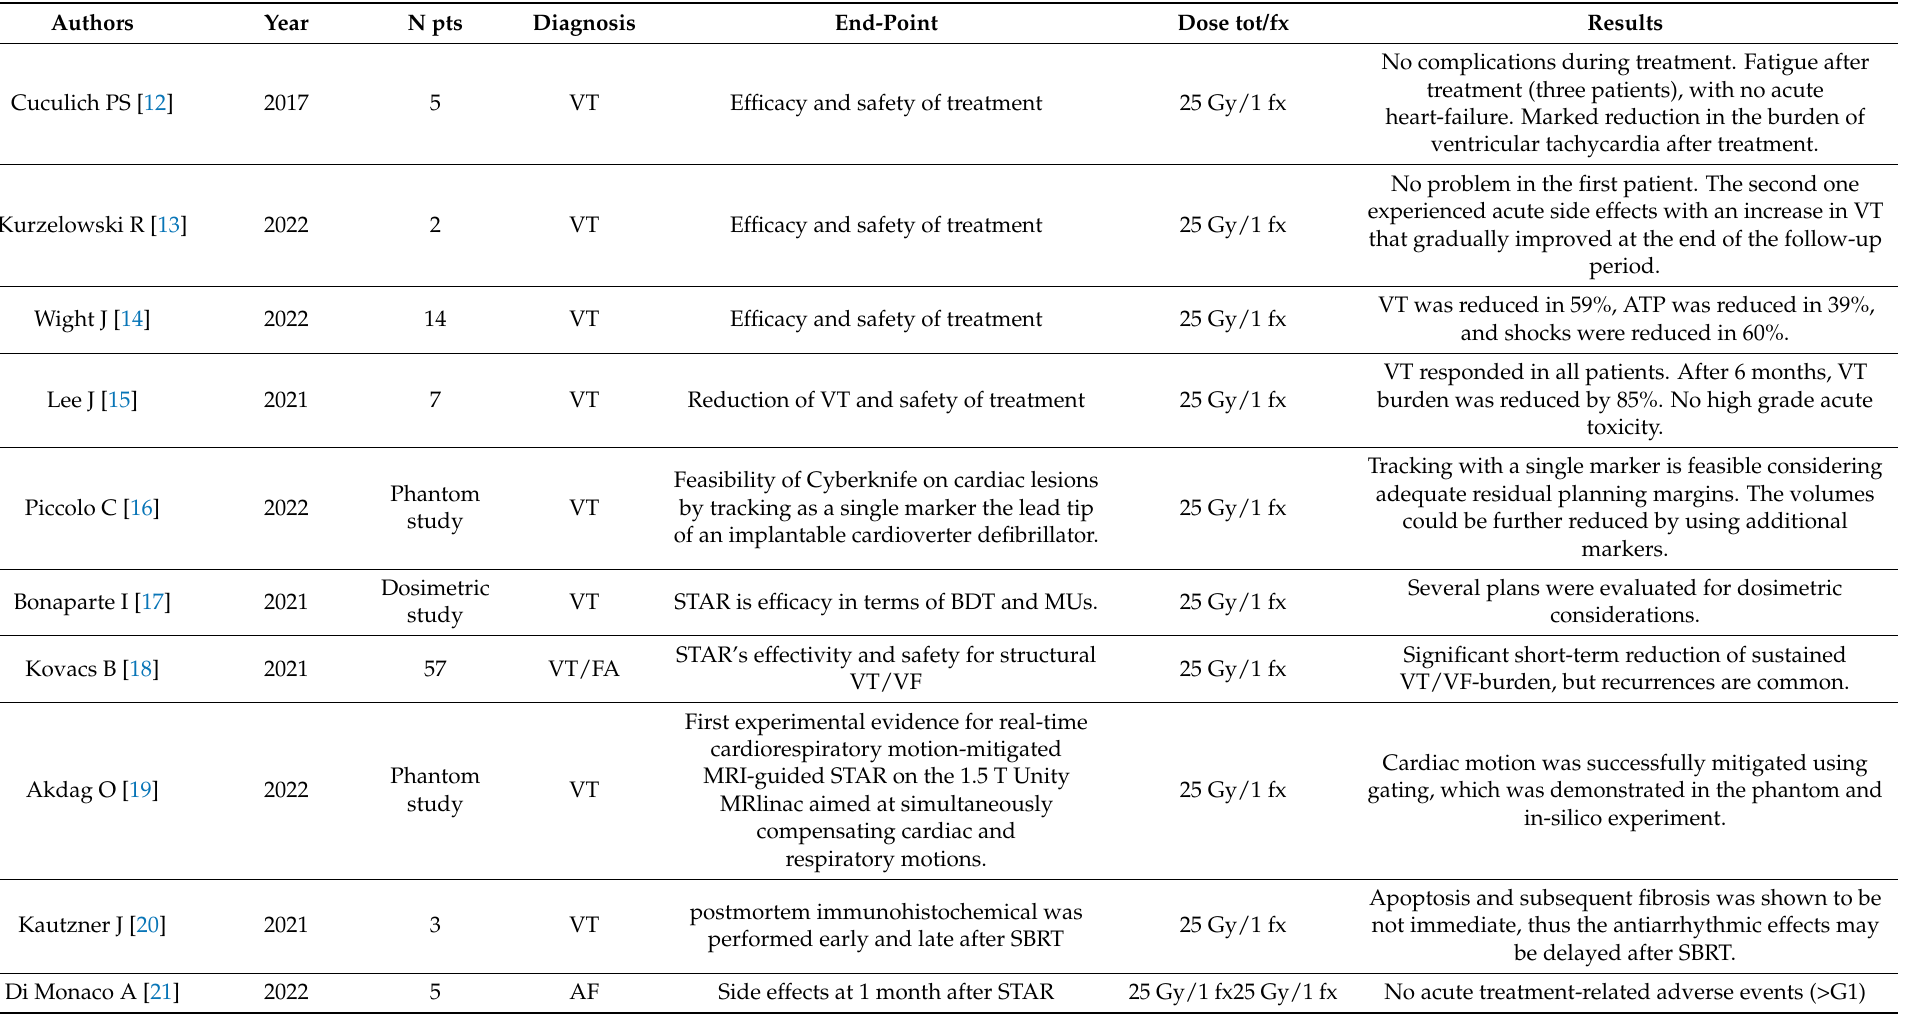
Table 1. Summary of evidence regarding ventricular tachycardia (VT) and atrial fibrillation (AF) treatment with stereotactic ablative radiotherapy